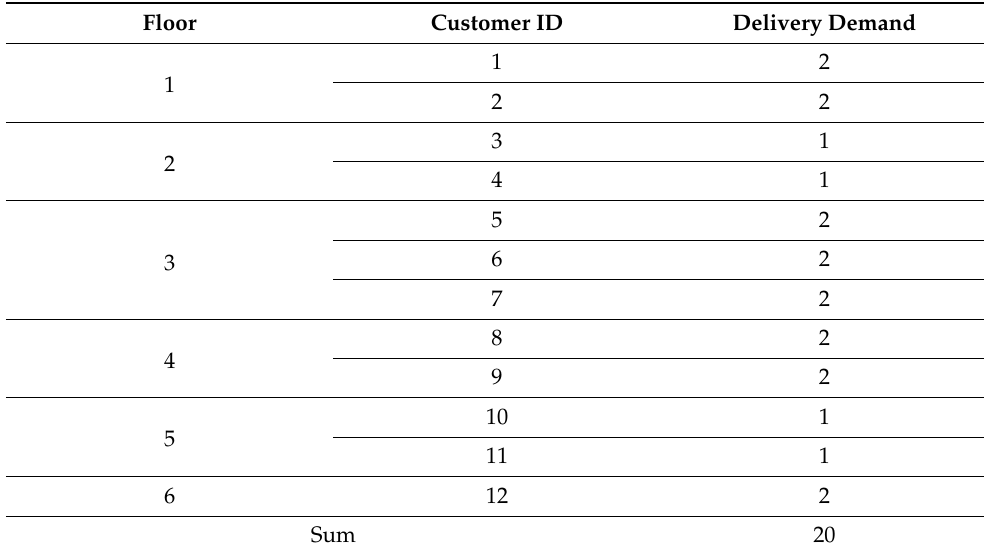
Table 3. Customer data in the building.